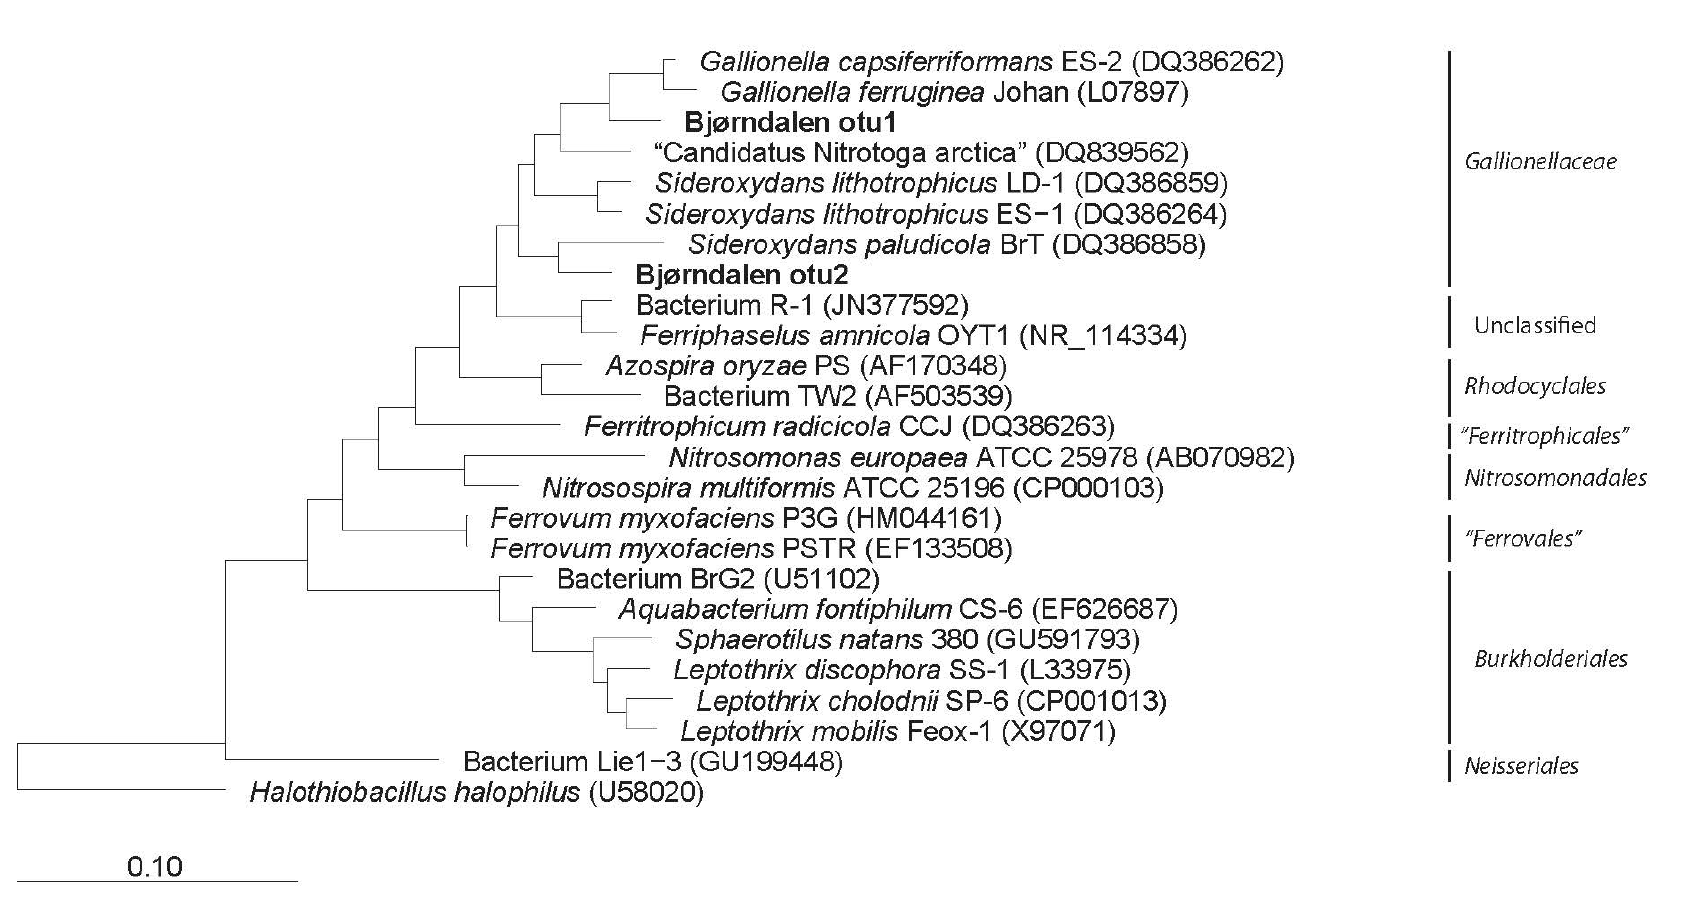
Figure A6. Maximum-likelihood tree showing the phylogenetic relationship between some known iron oxidizing bacteria and other bacteria within the Betaproteobacteria class. The relative position of the two different Gallionellaceae phylotypes retrieved from Bjørndalen are shown. The scale bar represents 10% nucleotide